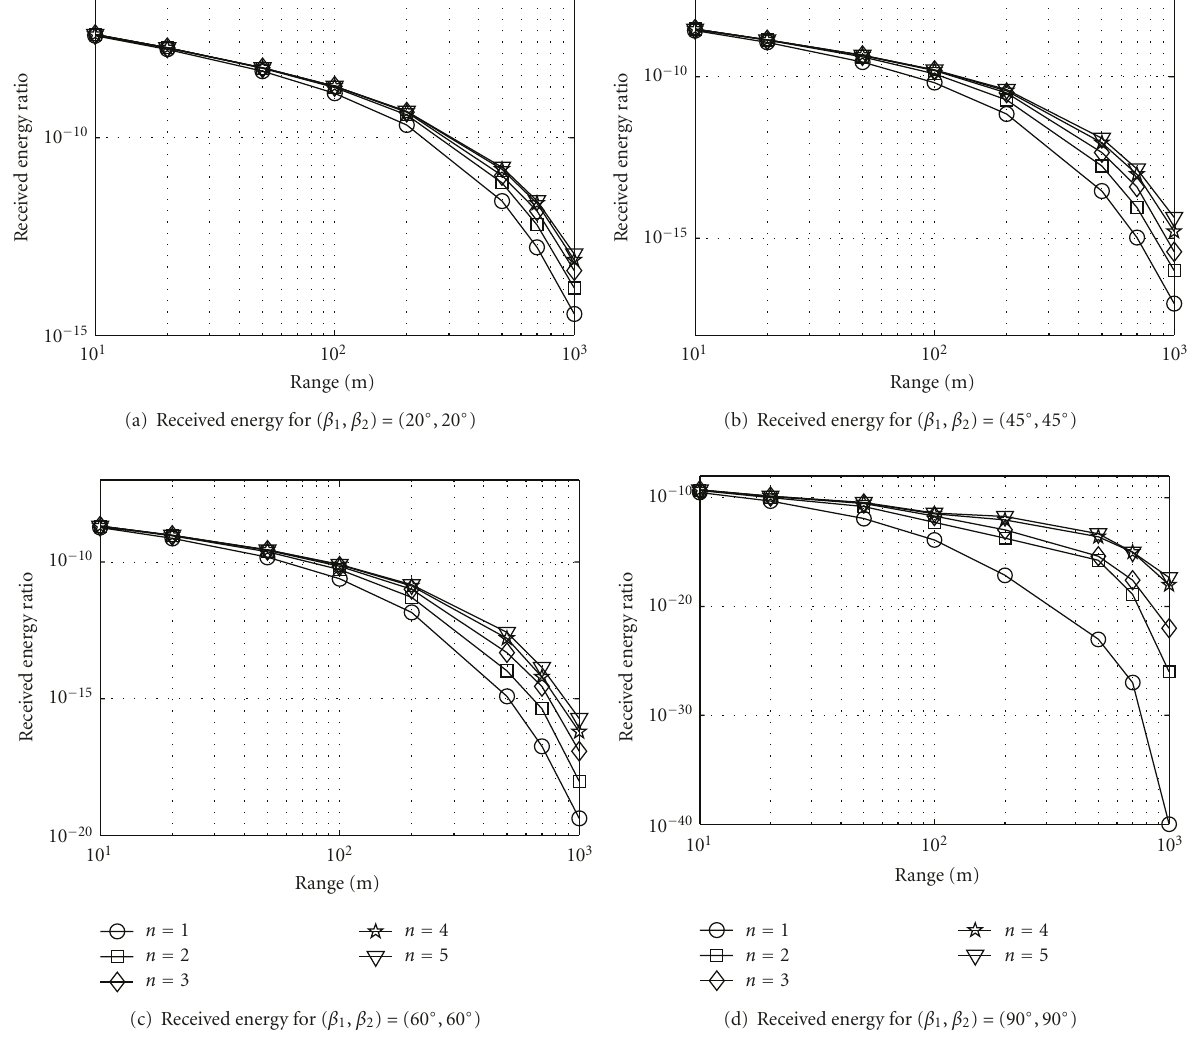
Figure 8: Received energy ratio for extra thick atmosphere predicted by the proposed